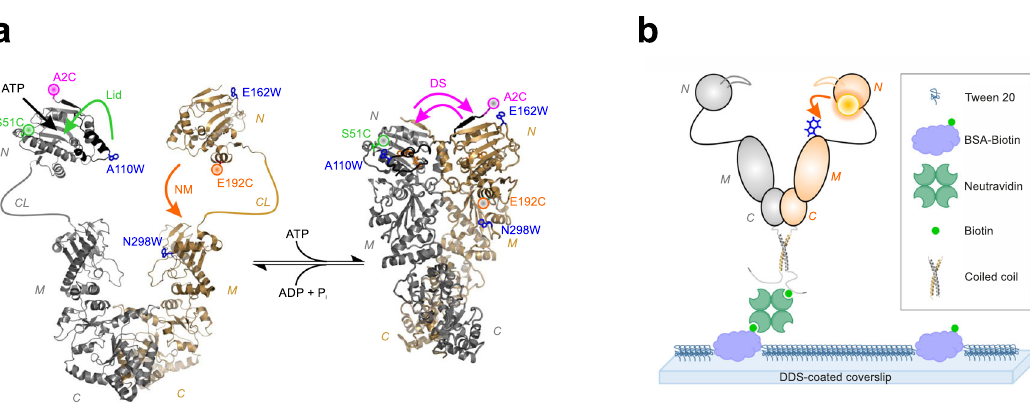
Fig. 1 PET fl uorescence reporter design and immobilization of Hsp90. a Left: Structural model of apo Hsp90 based on crystallographic data of the NTD (pdb id 1AM1) and the MC-domain (pdb id 2CGE). NTD (N), charged linker (CL), MD (M), and CTD (C) are indicated. The ATP-binding pocket is indicated by a black arrow. Right: Crystal structure of Hsp90 in closed-clamp conformation with bound AMP-PNP (pdb id 2CG9). Mutations and fl uorescence modi fi cations (coloured spheres) constituting the PET reporters for Lid (green), NM-association (orange) and DS (magenta) are highlighted. Conformational changes initiated by binding of nucleotide and probed by PET reporters are indicated by coloured arrows. b Scheme of sm immobilization of hetero-dimeric Hsp90. A PET fl uorescence reporter for NM-association is indicated